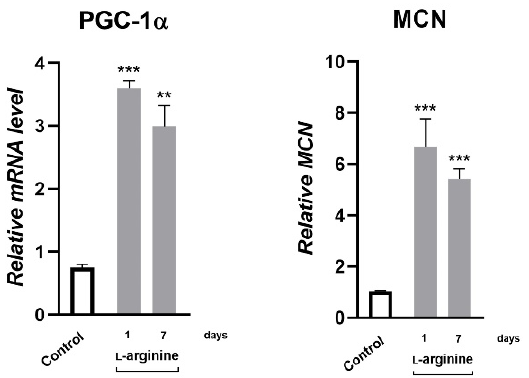
Figure 4. Peroxisome proliferator-activated receptor-gamma coactivator—1 α (PGC-1 α ) gene expression and mitochondrial DNA copy number (MCN) level increase in retroperitoneal white adipose tissue (rpWAT) upon 1 and 7 days of 2.25% L -arginine · HCl treatment. * Comparison with control ( n = 6 per group); ** p < 0.01, *** p < 0.001.